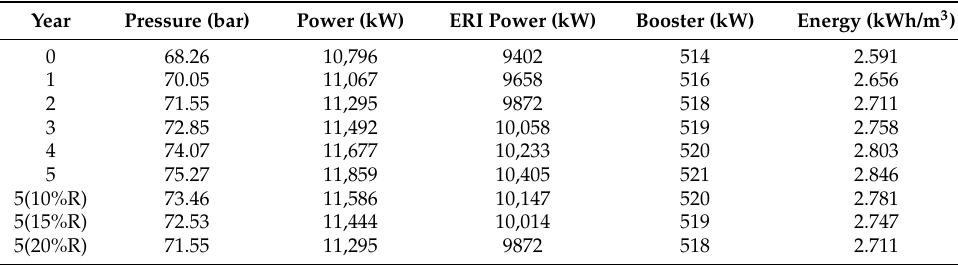
Table 7. Pressure, Power, and Energy consumption at 22 ◦